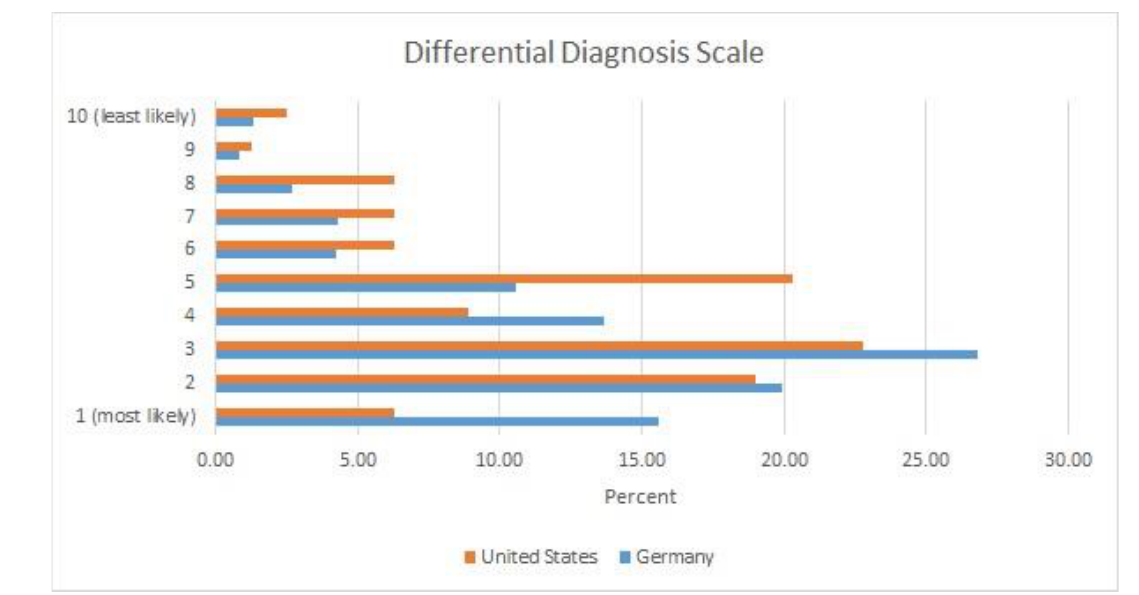
Figure 1. Differential Diagnosis Scale. Answers to the question: “Where on your own list of differential diagnoses should child abuse be located for you to consider reasonable suspicion/gewichtige Anhaltpunkte for abuse?”.